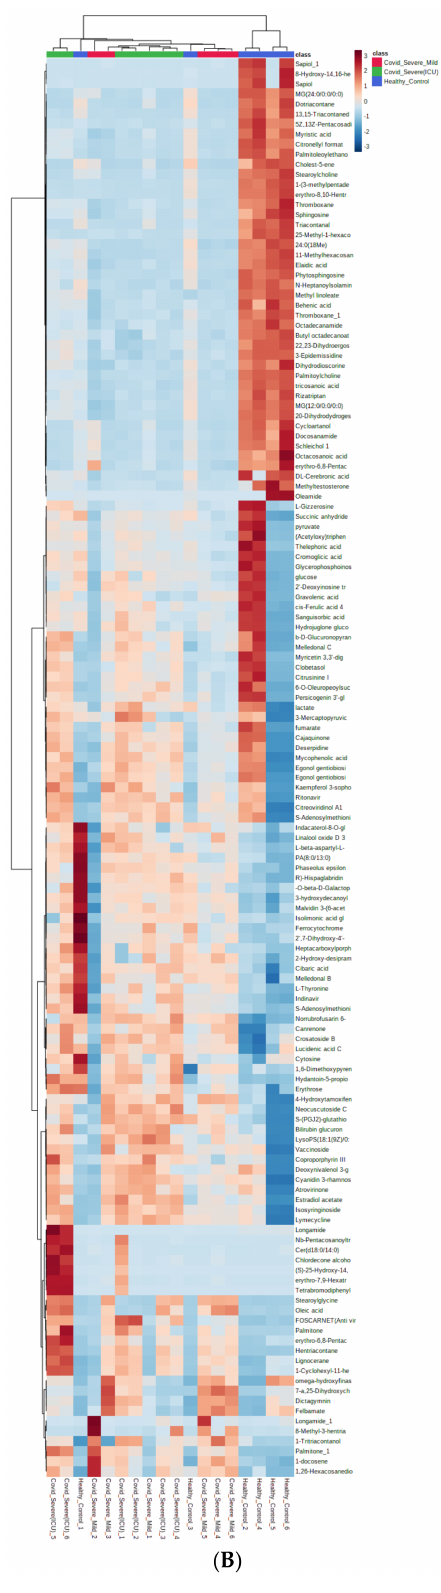
Figure 3. Correlation and expression of identified metabolites from both control and patient samples. ( A ) Correlation analysis of differentially modulated metabolites identified in both healthy and COVID-19 patient samples. ( B ) Clustering result is shown as a heatmap (distance measure using Euclidean distance and clustering algorithm using Ward heat map of individual